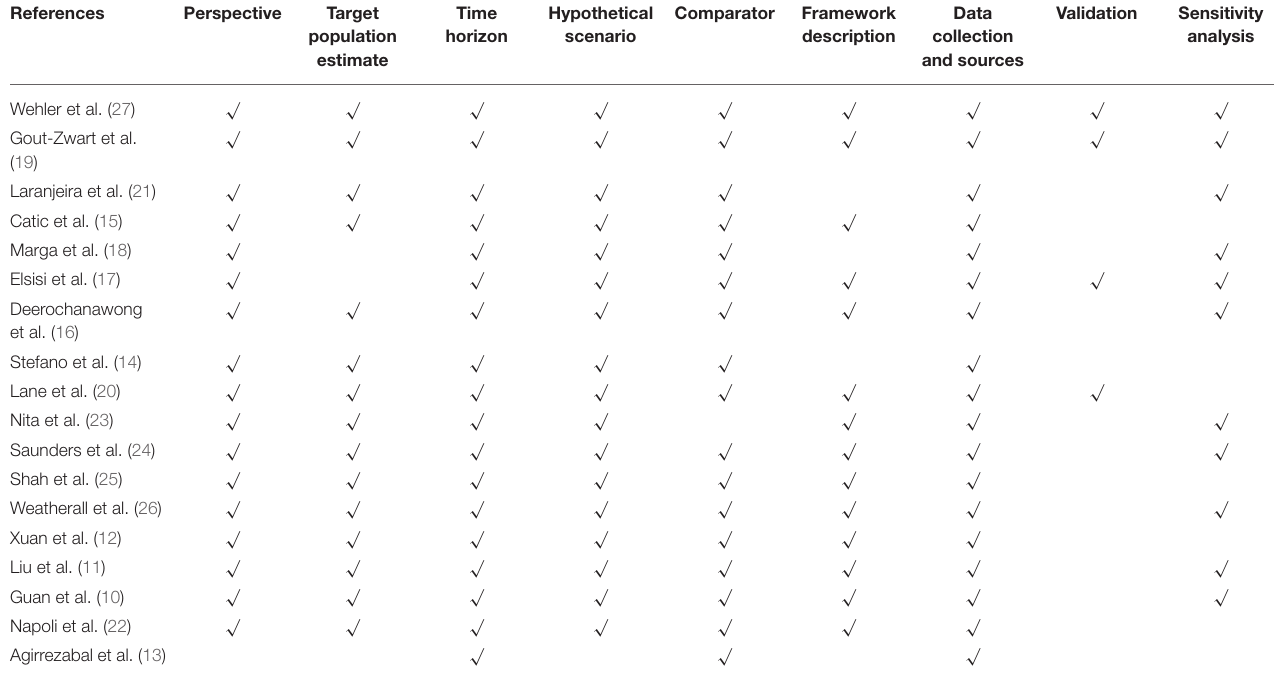
TABLE 3 | Guideline compliance of the included